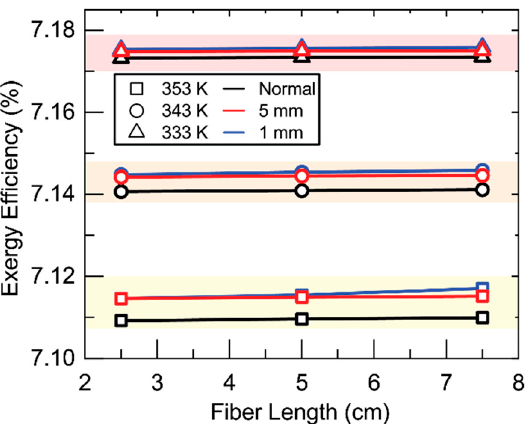
Figure 9. Exergy efficiency as fiber length changes at various baffling spacings. Shell-side feed. Inner radius 350 µm, thickness 300 µm, R / a 0.35, feed velocity 5 m/s, vacuum pressure 5 kPa, tor- tuosity 2, pore diameter 400 nm, porosity